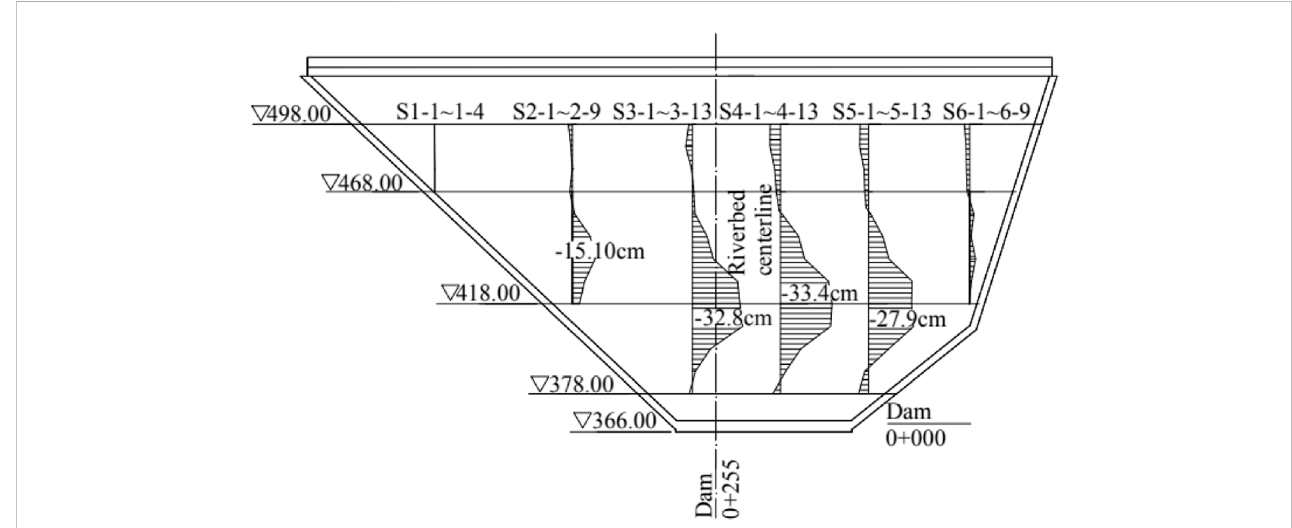
FIGURE 8 Displacement of wall extrusion along the river in March 2014.